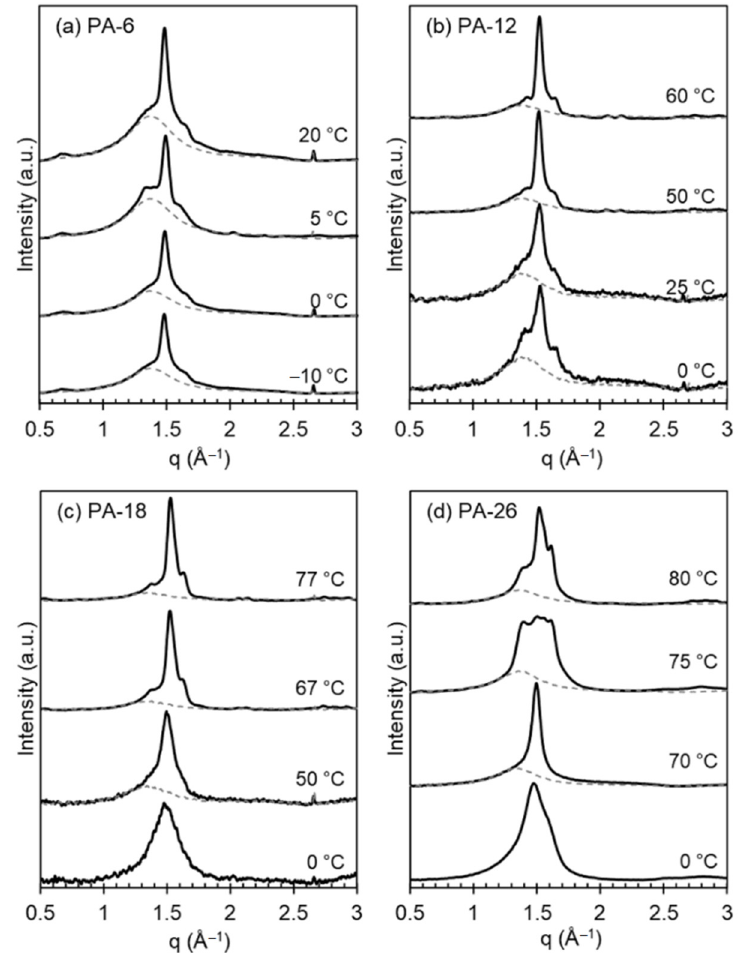
Figure 3. Wide-angle X-ray diffractograms (WAXD) for ( a ) PA-6, ( b ) PA-12, ( c ) PA-18, and ( d ) PA-26 crystallized or quenched at the temperatures indicated. Data have been vertically shifted for clarity. Dashed gray lines representing the experimental amorphous halo.